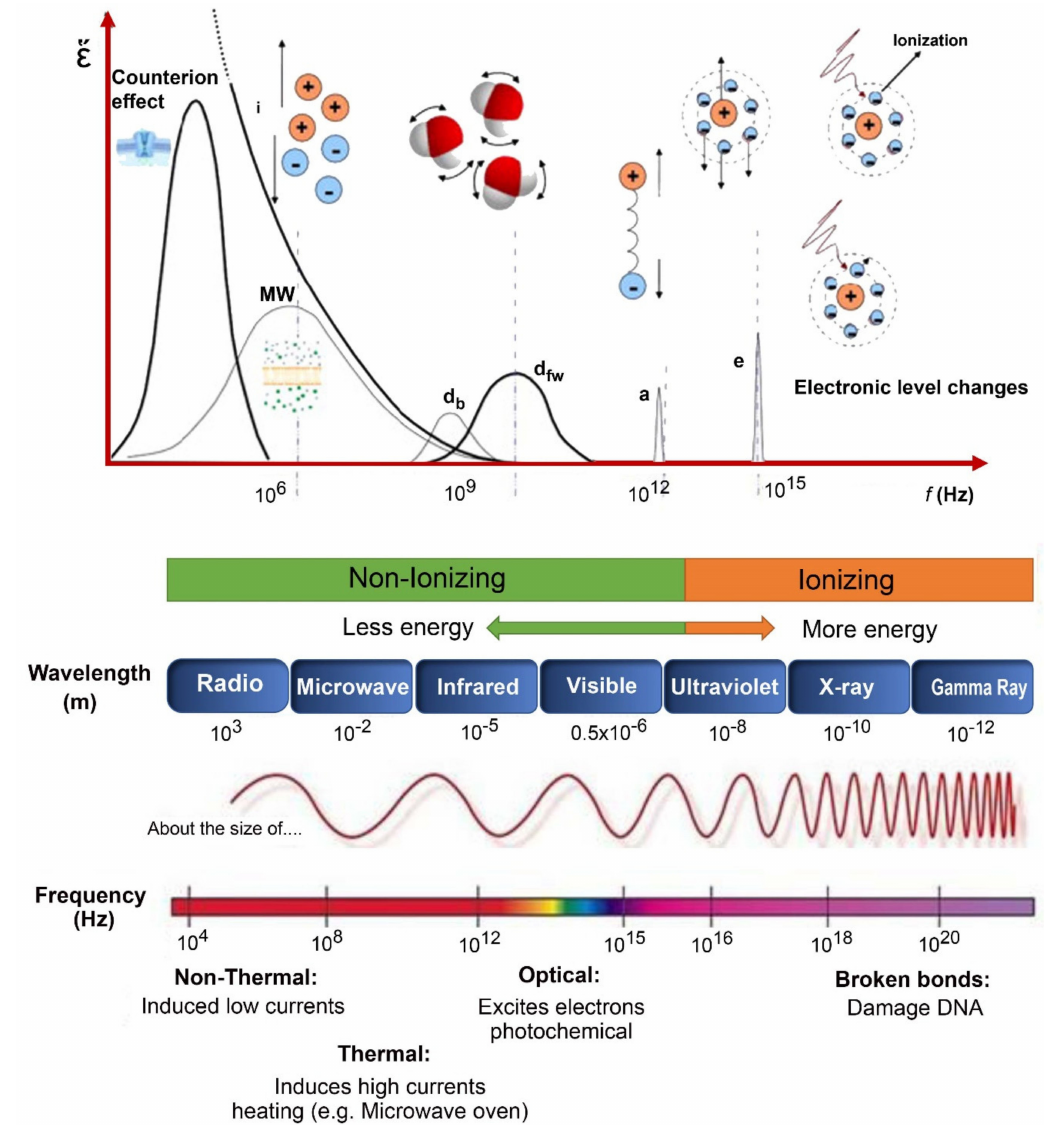
Figure 1. Schematic representation of the electromagnetic spectrum of the different effects that contribute to effective loss factor (modified from